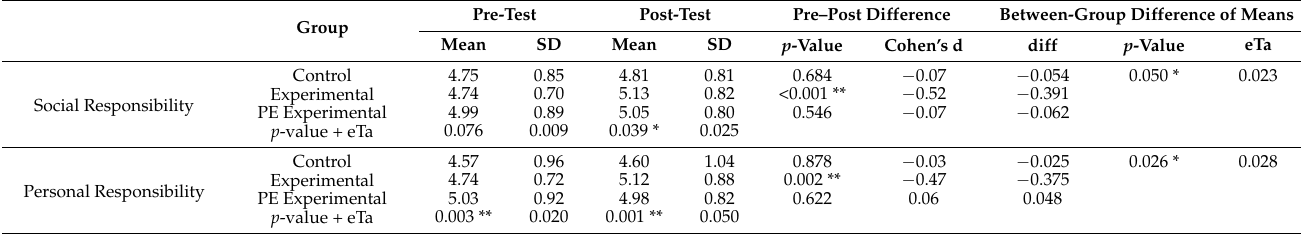
Table 8. Personal and social responsibility results.